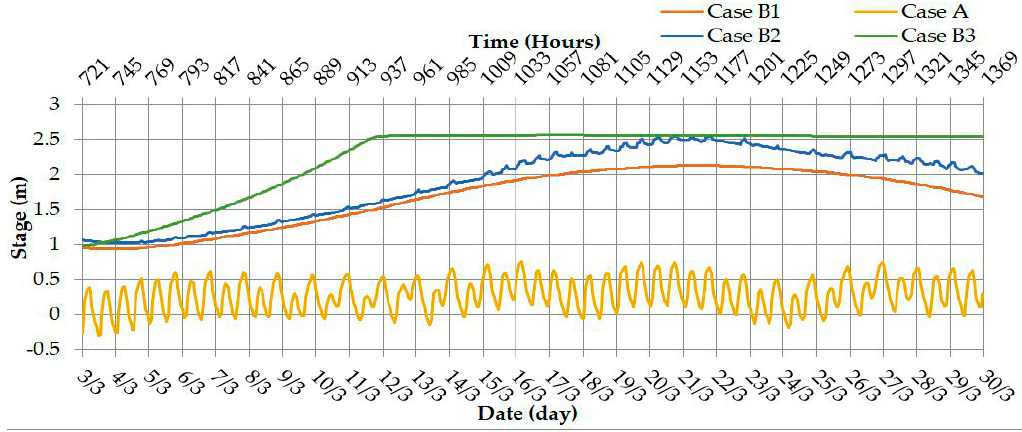
Figure 17. The stage in section no. 2.4 during the period of wave occurrence.